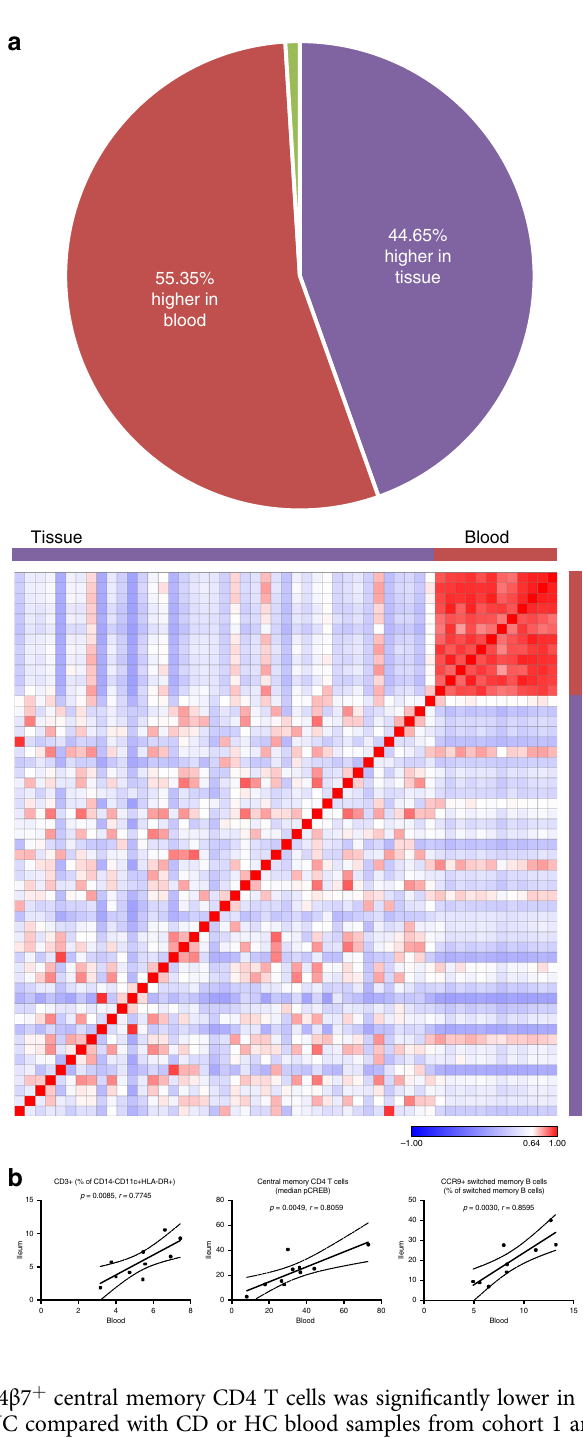
α 4 β 7 + central memory CD4 T cells was signi fi cantly lower in all UC compared with CD or HC blood samples from cohort 1 and higher in in fl amed UC tissues compared with in fl amed CD tissues in cohort 2, suggesting greater tissue localization and/or activation in UC (Supplementary Fig. 5a). CREB promotes Th17 cell differentiation and inhibits iTreg survival, which is consistent with IBD pathophysiology 35 – 37 . CCR9 + switched memory B cell frequency was signi fi cantly higher in the circulation of UC fl are compared with remission in cohort 1 (Supplementary Fig. 5b). While CCR9 + switched memory B cell frequency was these cells was signi fi cantly higher in UC than CD tissue (Supplementary Fig. 5b). The increase of CCR9 + B cells we observed in the blood and tissue of UC fl are was surprising, given